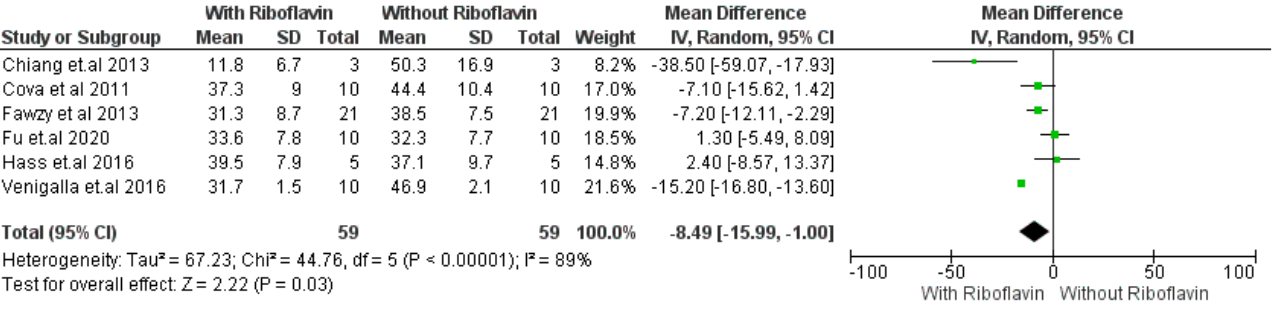
Figure 2. Forest plot of micro tensile bond strength of adhesive with 0.1% RF crosslinker-i. Metaanalysis evaluated the micro tensile bond strength of the dentin bonding system with and without the use of 0.1% riboflavin [18,23,26,30–32] after immediate (24 h) storage.